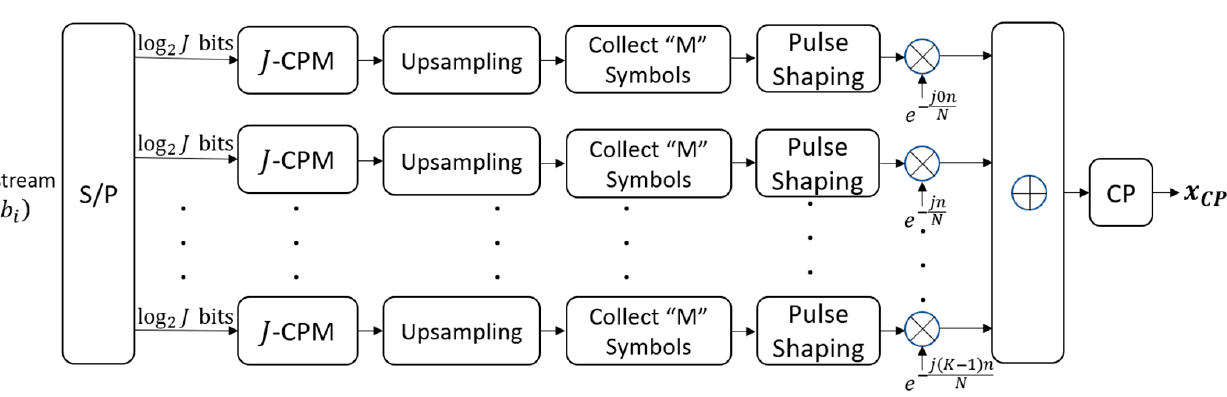
Figure 1. Proposed CPM-GFDM Transmitter .